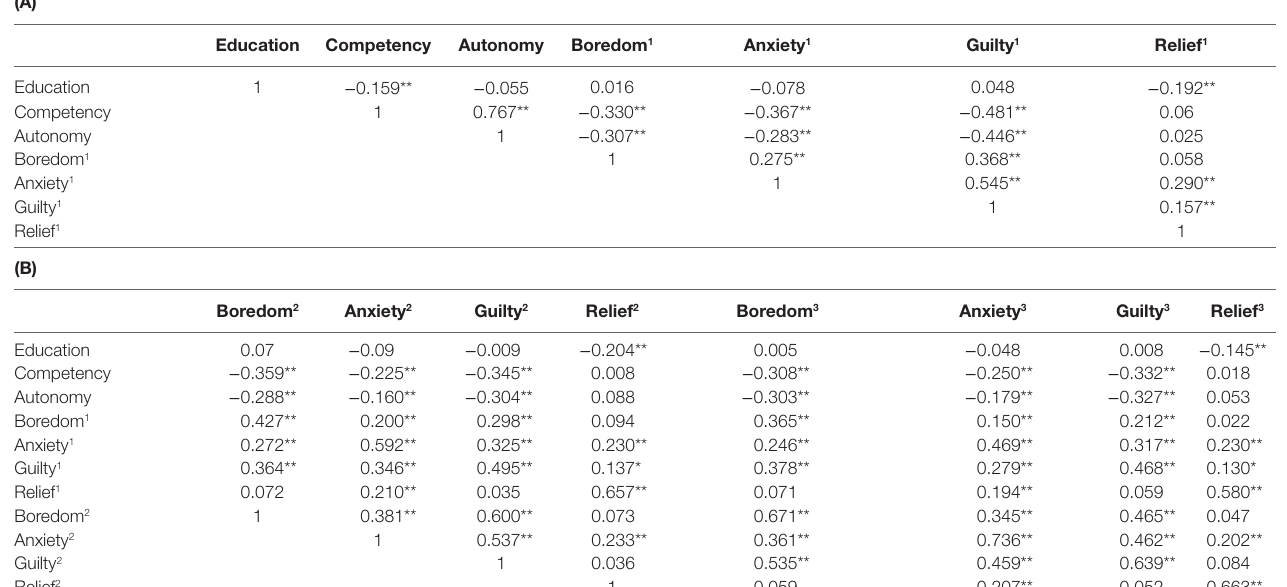
Table 3 | Correlations of all